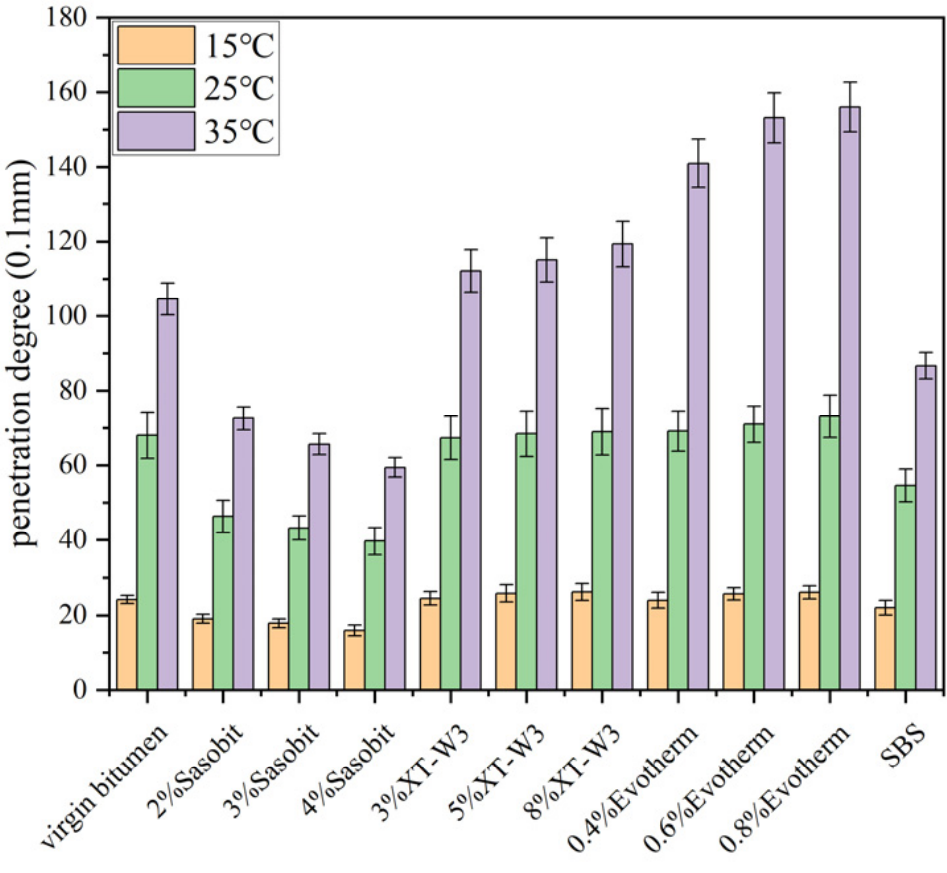
Figure 1. Penetration test results.